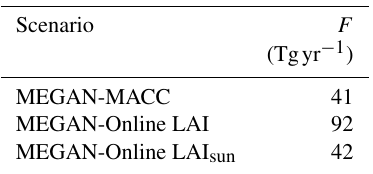
Table 5. Global acetone emission flux F (Tgyr − 1 ) for the scenarios of Fig. 7 calculated for the year 2004. Prescribed anthropogenic and biomass burning emissions are included and account for 1.2 and 2 . 2Tgyr − 1 , respectively.